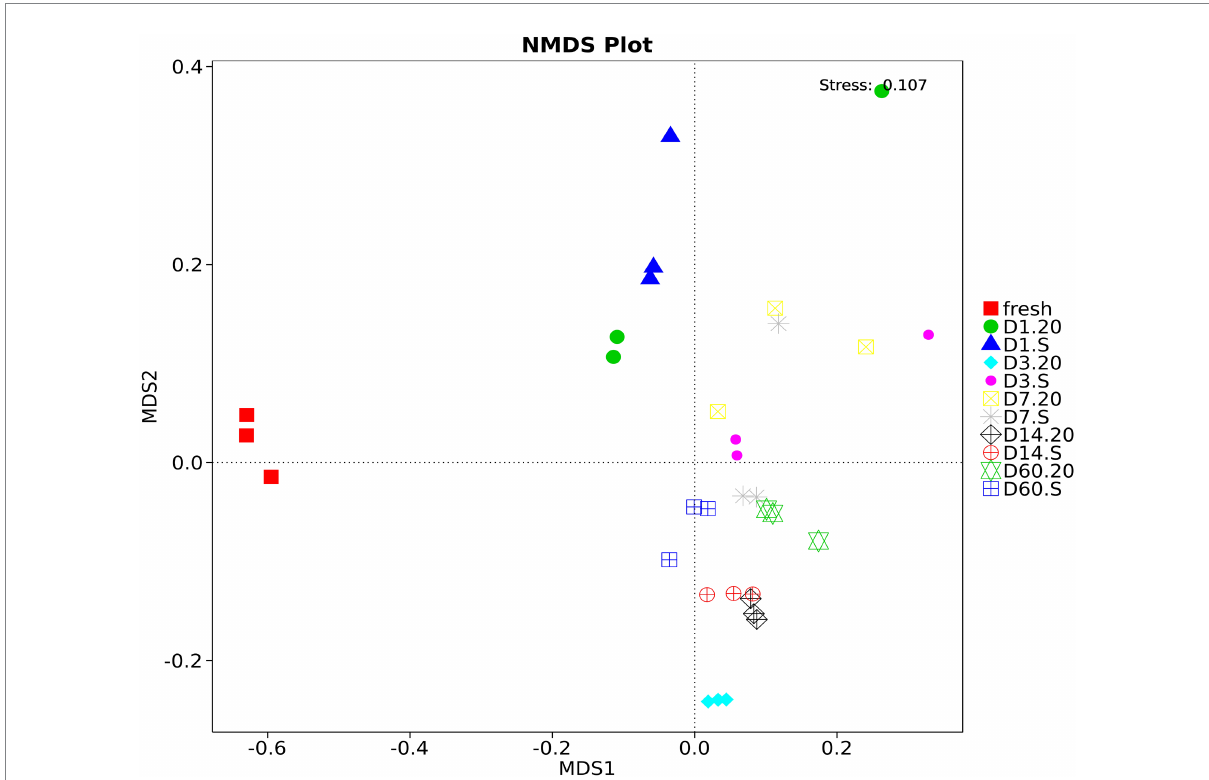
FIGURE 6 Non-Metric Multi-Dimensional Scaling (NMDS) analysis of oat silage stored at different conditions. Different samples are represented by different colors. 20, constant temperature of 20 ° C; S, freeze–thaw condition, alternating 20 and − 5 ° C every 12